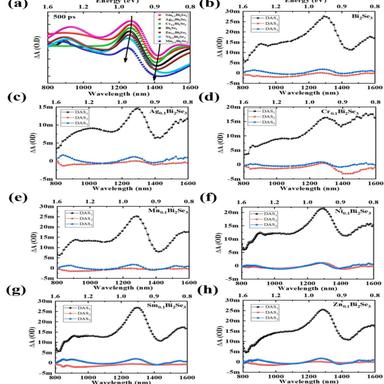
(a) shows the shift in ΔR at 500 fs of MIBS. The decay-associated spectra (DAS) of (b) Bi2Se3, (c) Ag0.1Bi2Se3, (d) Cr0.1Bi2Se3, (e) Mn0.1Bi2Se3, (f) Ni0.1Bi2Se3, (g) Sm0.1Bi2Se3, (h) Zn0.1Bi2Se3.